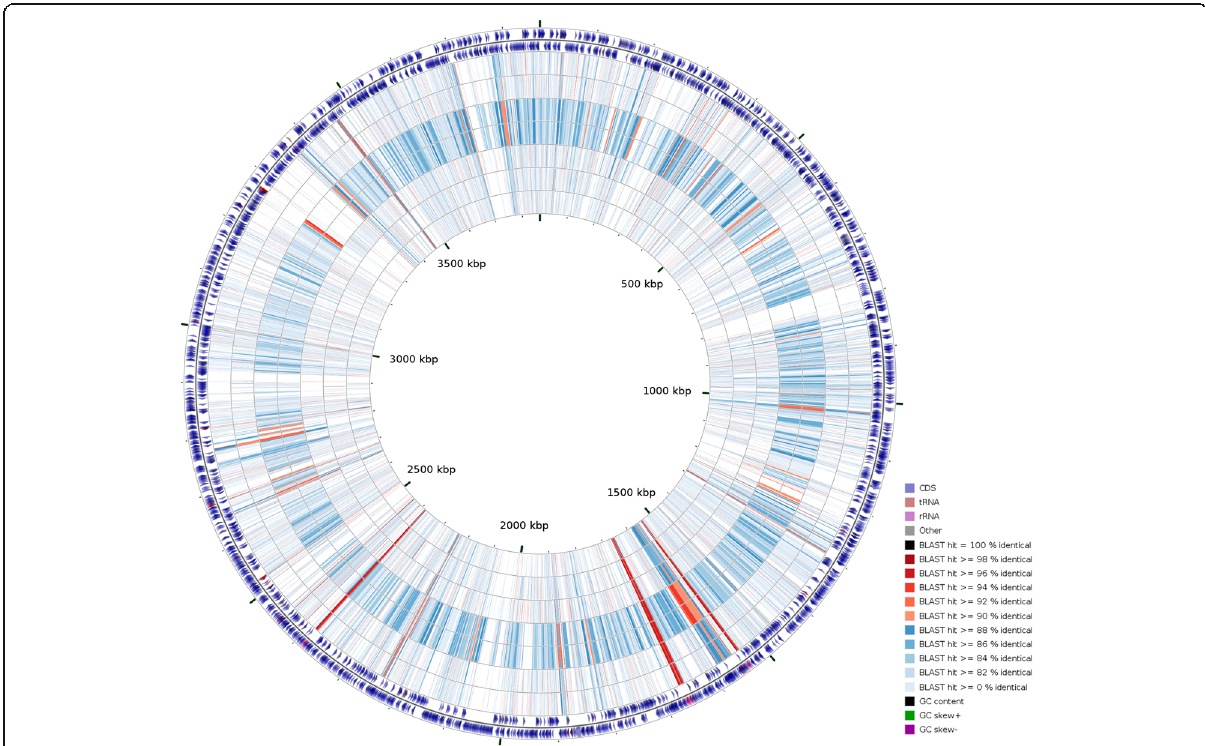
Fig. 4 Circular map comparing strain CCB-MM1 genome and seven other Microbulbifer genomes generated using CGView Comparison Tool [44]. The two outermost rings represent forward and reverse sequence features respectively. The remaining seven rings show the regions of sequence similarity detected by BLAST comparisons conducted between nucleotide sequences from the CCB-MM1 genome and seven other Microbulbifer genomes with the order (from outside) as follow: Microbulbifer elongatus HZ11, Microbulbifer sp. Q7, Microbulbifer sp. WRN-8, Microbulbifer sp. ZGT114, Microbulbifer agarilyticus S89, Microbulbifer thermotolerans DAU221 and Microbulbifer variabilis ATCC 700307